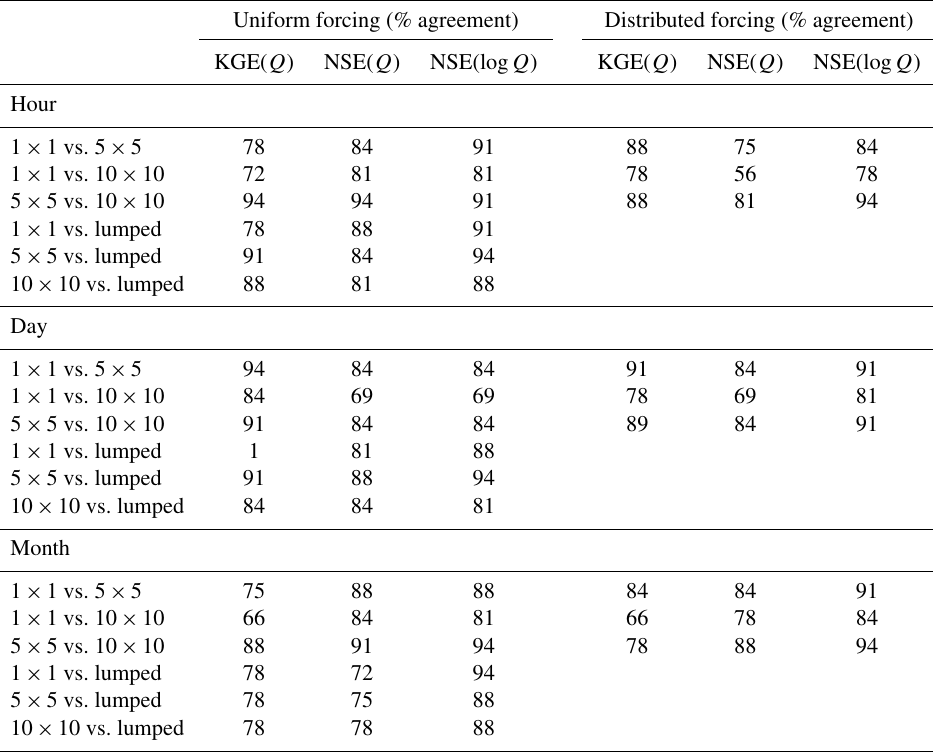
Table 2. Transferability of parameters across spatial resolution, expressed as percentage agreement in detected behavioural runs for different spatial resolutions (in km) at different time steps.